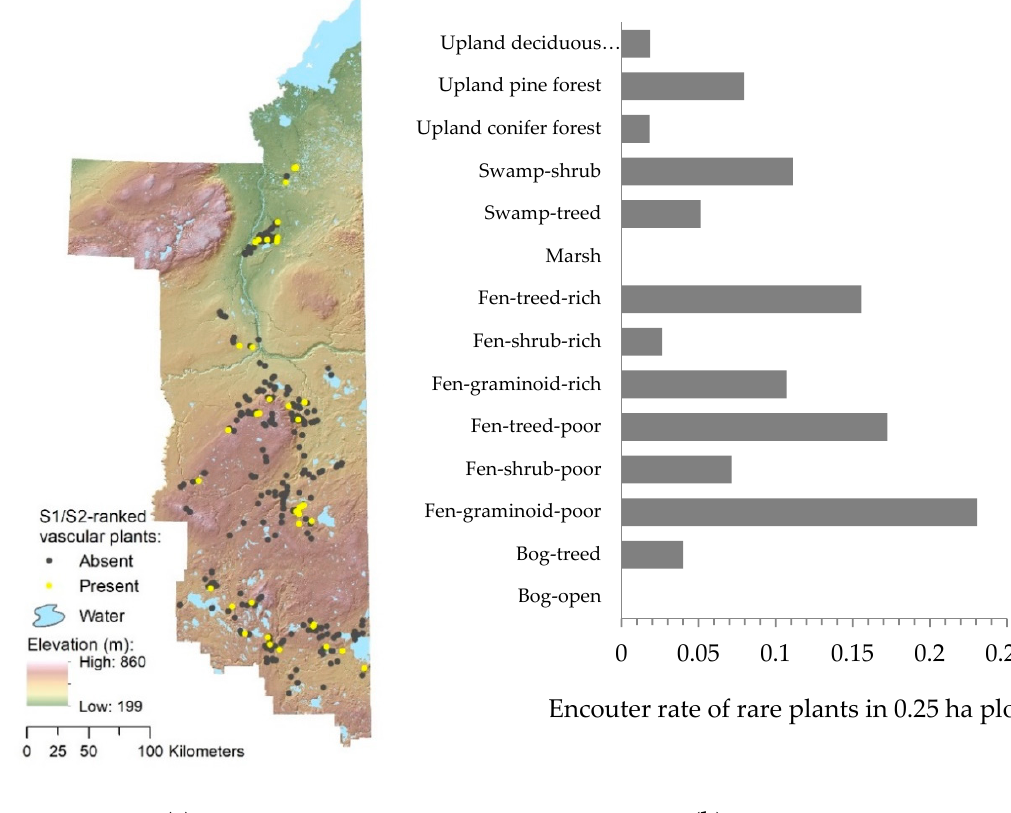
Figure 3. ( a ) Distribution of field plots ( n = 602) relative to the region terrain and the location (presence) of detected rare (S1 and / or S2 ranked) vascular plants (shown as yellow locations) within 0.25 ha plots in the Lower Athabasca region of Alberta, Canada; ( b ) encounter rate of rare (S1 and / or S2 ranked) vascular plants by dominant land cover type based on the classification from the DU-EWC.